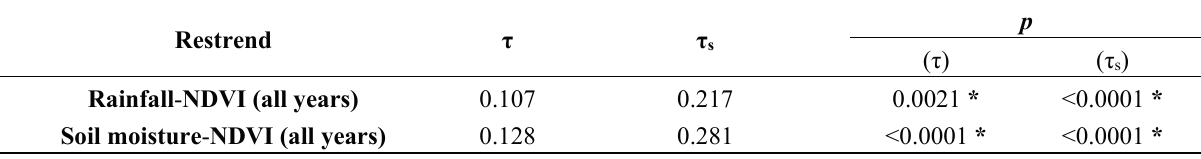
Table 1. Mann-Kendall’s trend analysis coefficients: Annual τ and seasonal τ s